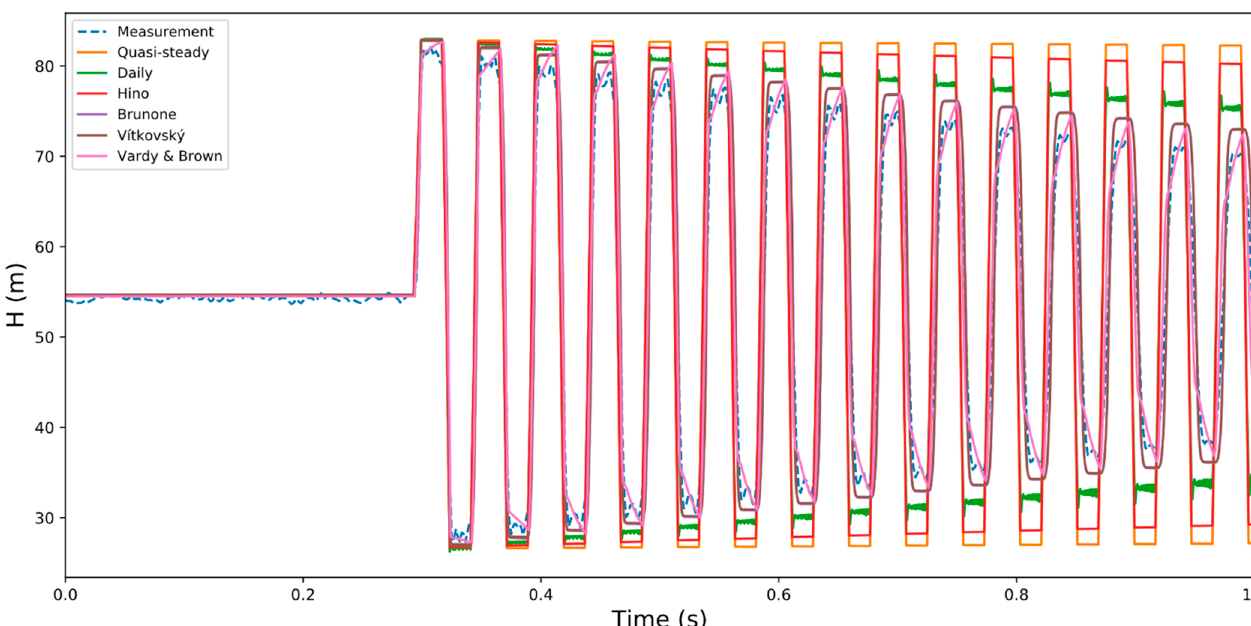
Figure 3. Simulation of different friction models.